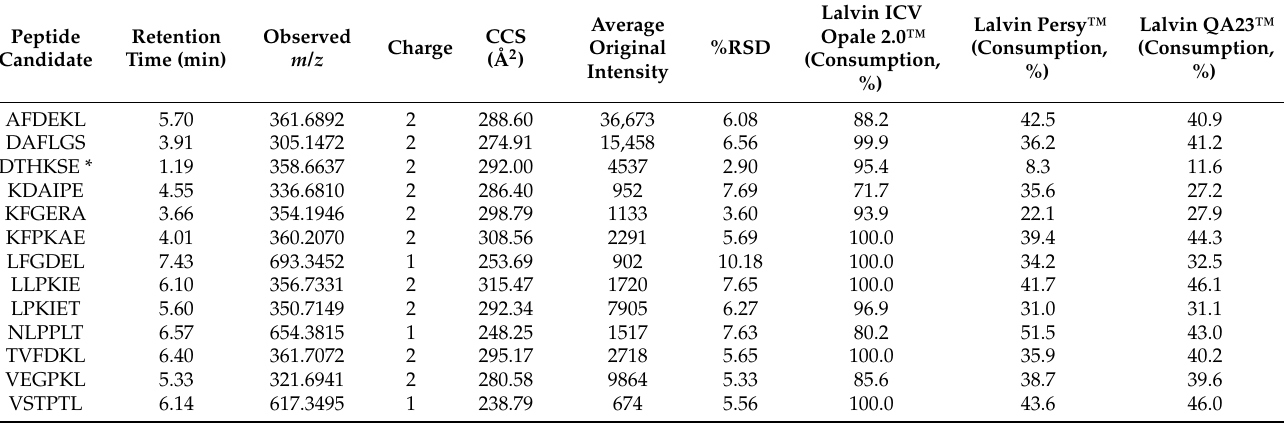
Table A8. The proposed hexapeptide sequences and observed relative consumption during fermenta- tion with Lalvin ICV Opale 2.0™, Lalvin Persy™ and Lalvin QA23™ of the modified synthetic must. Peptide sequences were acquired by peptide mapping to bovine serum albumin protein sequence (UniProtKB–P02769 (ALBU_BOVIN)). * Elution within void volume. Additionally presented are the retention time, observed m/z , collision cross section values, as well as the averaged peptide intensities at the starting point and associated relative standard